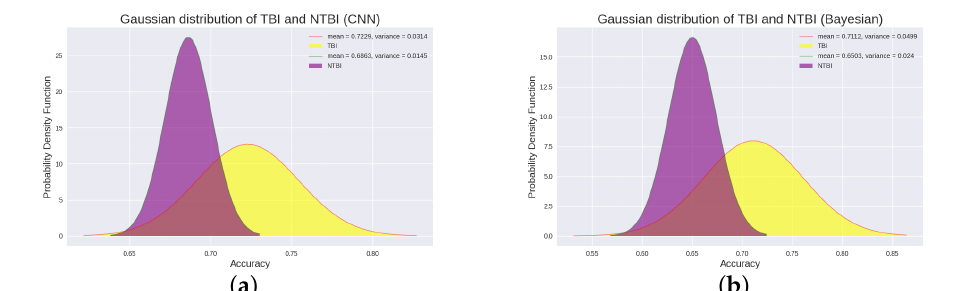
Figure 5. Panel ( a ) describes the Gaussian distribution between TBI patients and NTBI patients using the CNN method. Panel ( b ) depicts the Gaussian distribution between TBI patients and NTBI patients using the Bayesian method. The probability distribution of “TBI” patients and “NTBI” patients. The yellow one is the Gaussian distribution fitted to the P300 detection accuracy of the “TBI” patients, and the purple one is the Gaussian distribution fitted to the P300 detection accuracy of the “NTBI” patients. From the probability distribution plot, we found that the P300 signal differed between TBI patients and NTBI patients. This is also an important manifestation of P300-based technology for classifying TBI patients and NTBI patients.